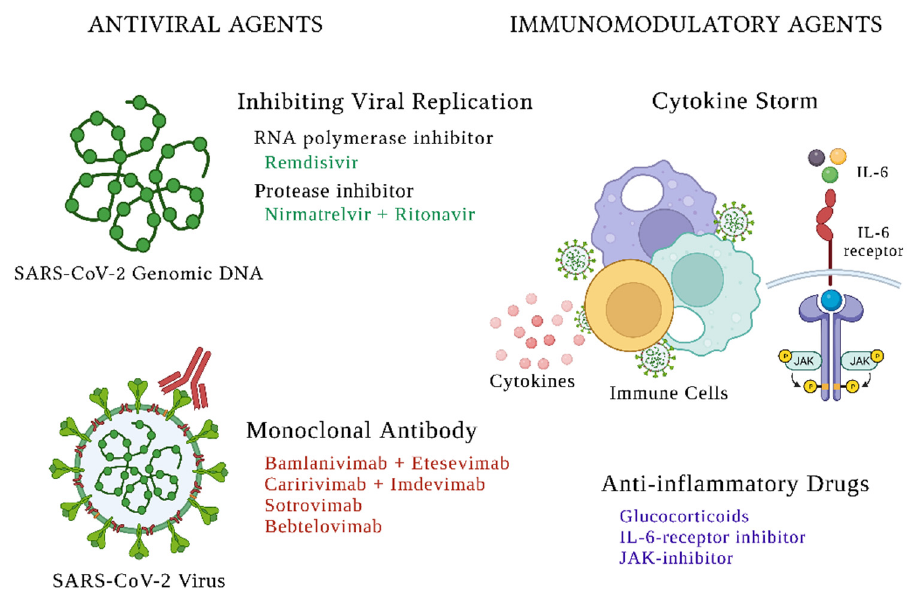
Figure 1. Mechanism of Action of Therapies Targeted Toward the SARS-CoV-2 Virus.